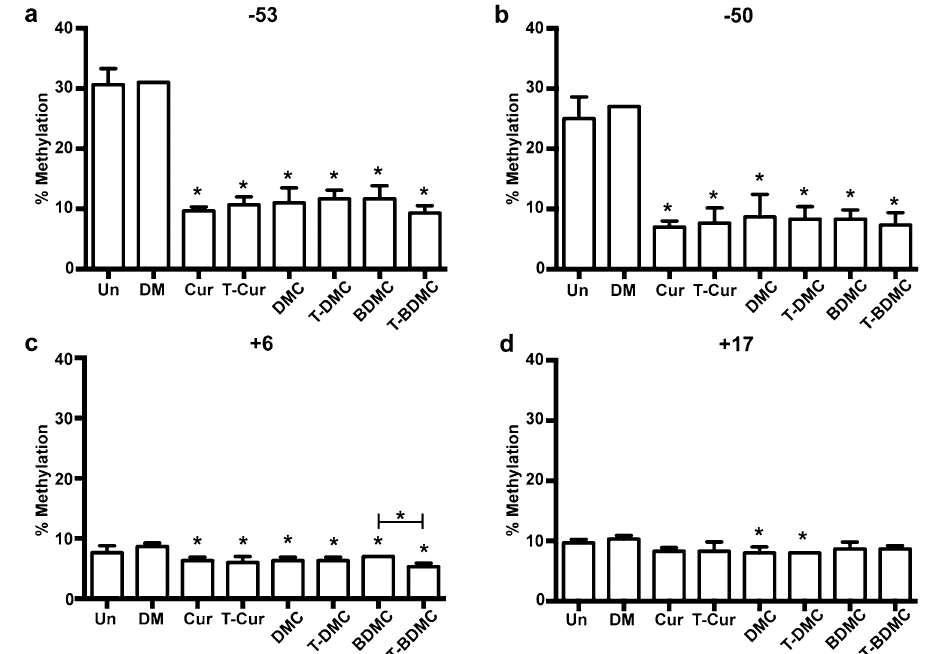
Figure 3. Curcuminoids and their trienone analogs decrease methylation of the G γ-globin promoter in K562 cells. The K562 cells were treated with the compounds for 5 days. DNA methylation at CpG ( a ) − 53, ( b ) − 50, ( c ) + 6 and ( d ) + 17 of the transcription start site were determined by bisulfite conversion and